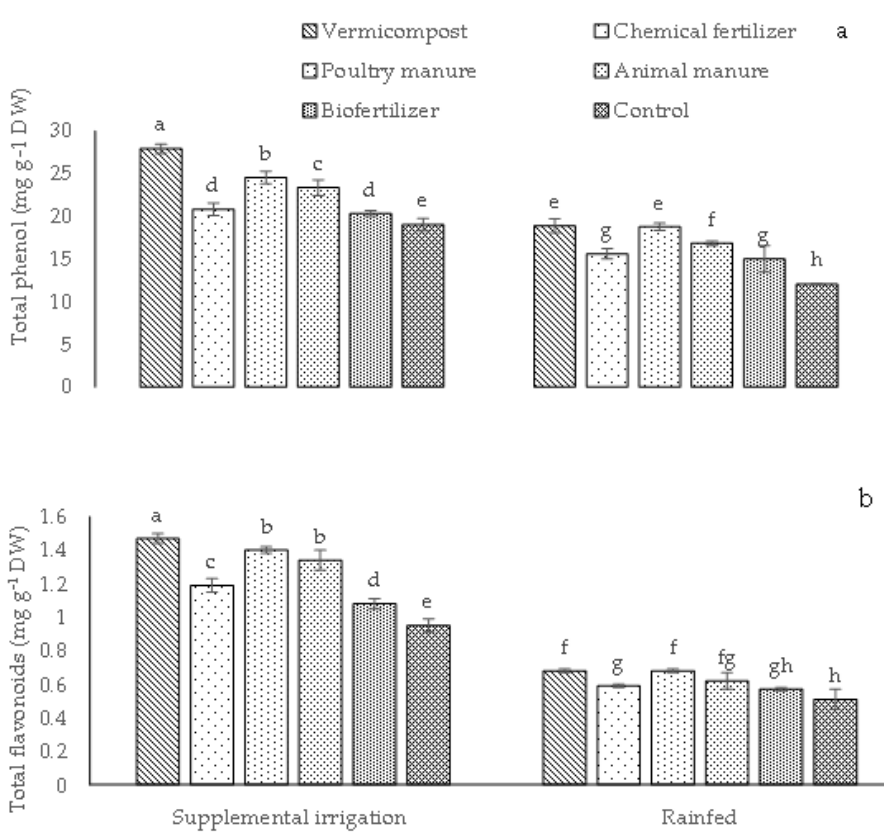
breaking activity capacity).